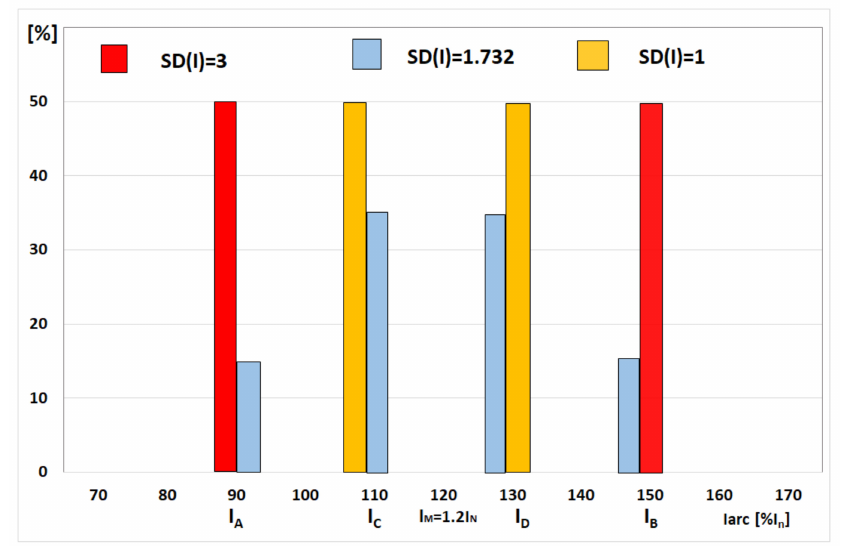
Figure 7. Histograms of arc furnace current changes in various stages of melting